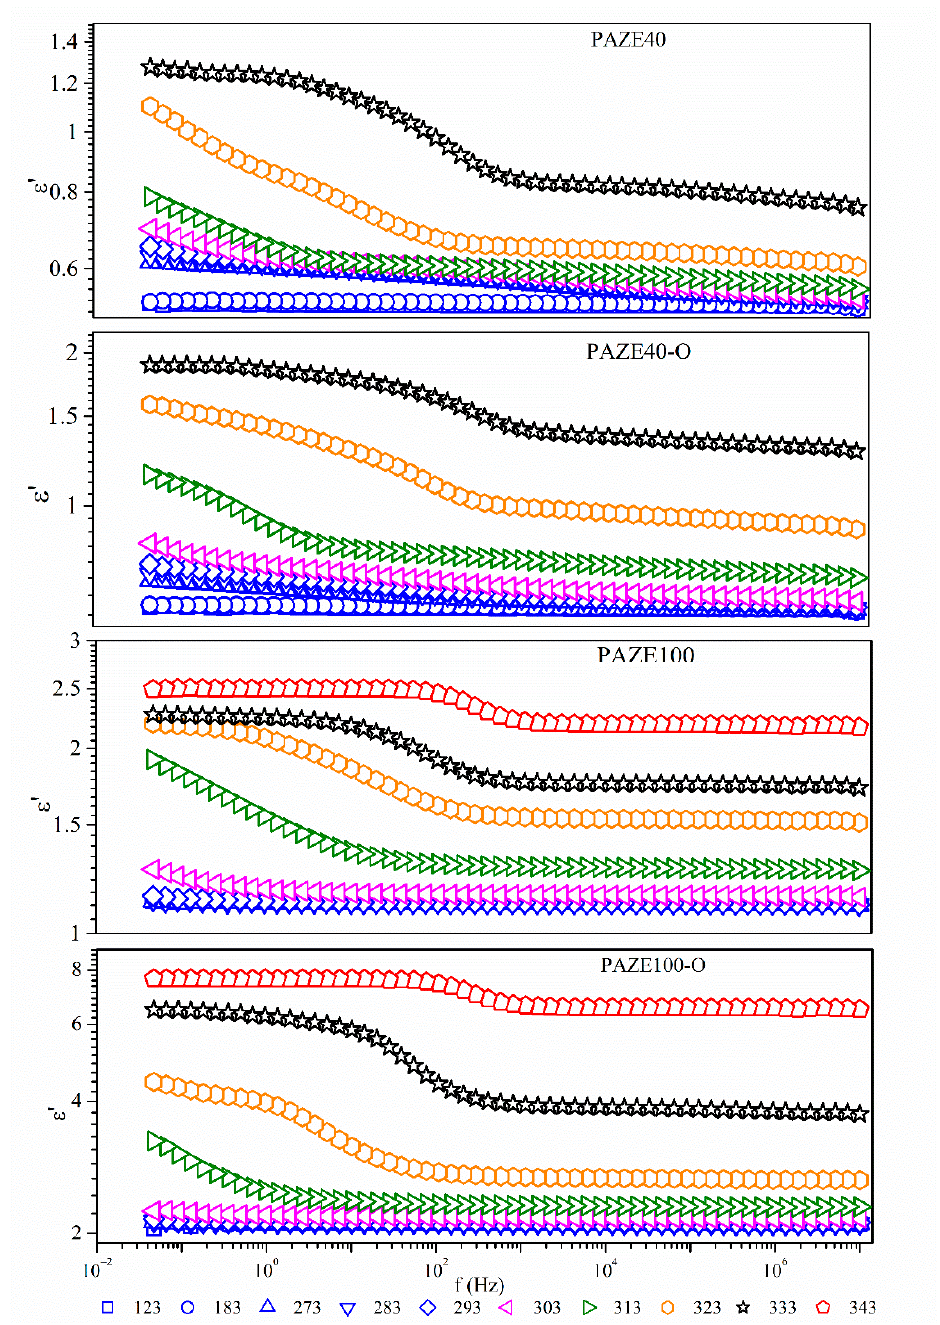
Figure 9. Isothermal curves (in K) of the real part of the dielectric permittivity ɛ ′ of the unoriented and oriented PAZE100 and PAZE40.